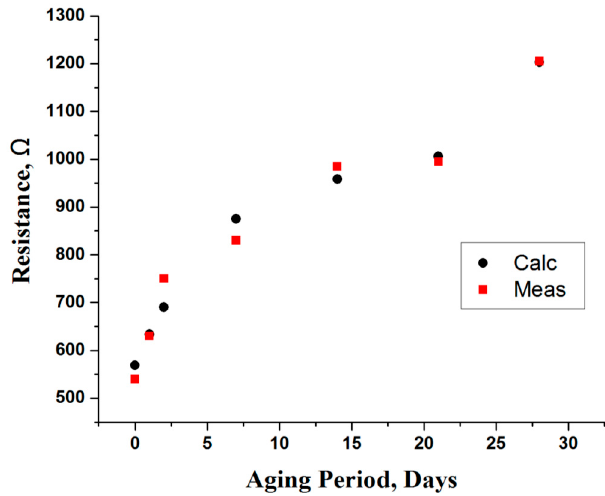
Figure 11. Resistance (R 2 ) of an extracellular fluid (ECF) as a function of aging period.